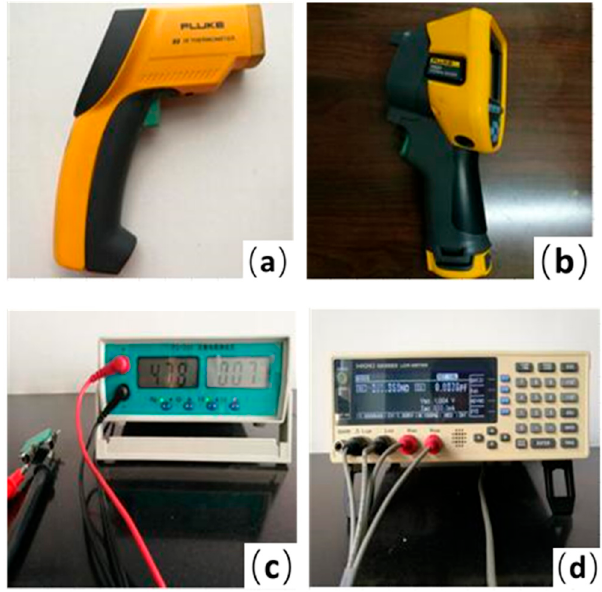
Figure 5. Experimental auxiliary measuring equipment. ( a ) Infrared thermometer, ( b ) Infrared thermal imager, ( c ) Varistor tester, ( d ) LCR tester.